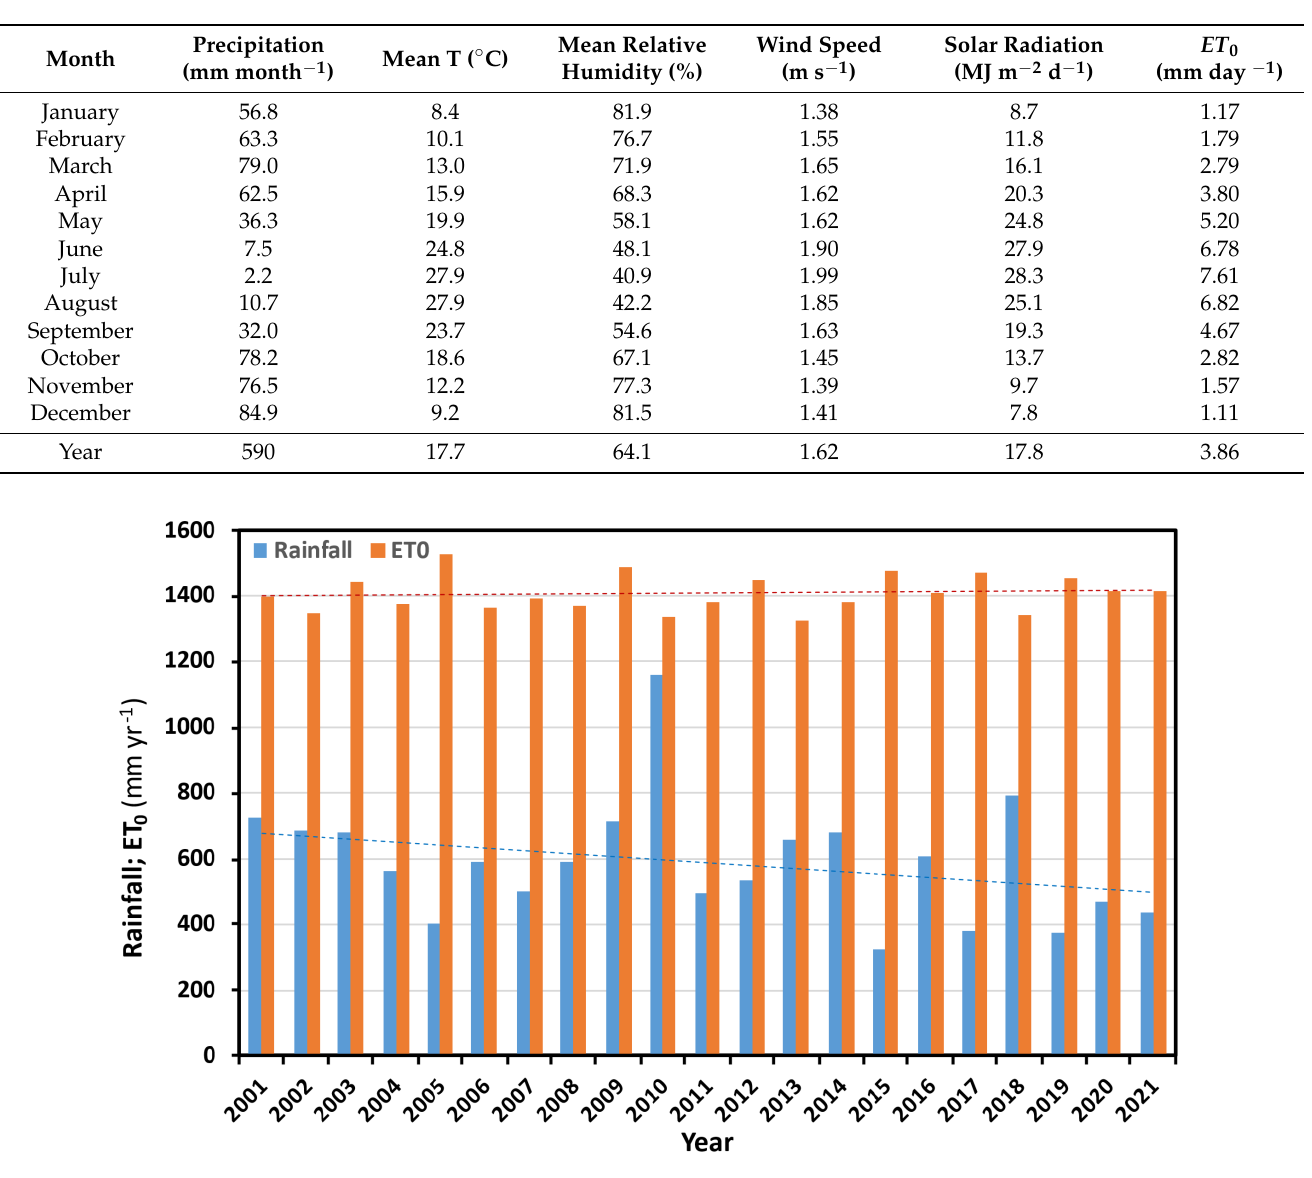
Table 1. Average climatic data in Córdoba (Andalusia; southern Spain) during the period from 2001 to 2021, obtained from the Córdoba agroclimatic station belonging to the Andalusian Agroclimatic Information Network (RIA).